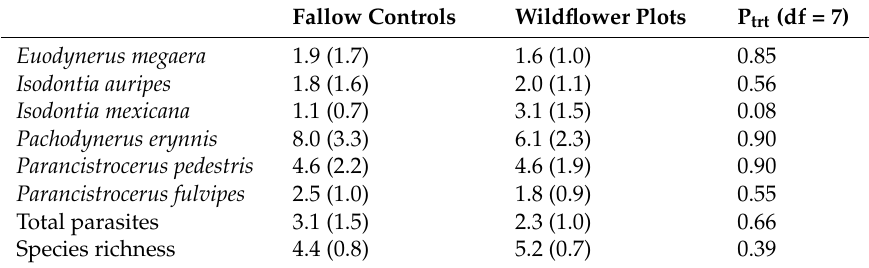
Table 4. Mean ( ± SE) abundance of occupied nests by the various wasp species, total parasites and species richness of wasps and bees collected April 2015–November 2015 between fallow control plots and augmented wildflower